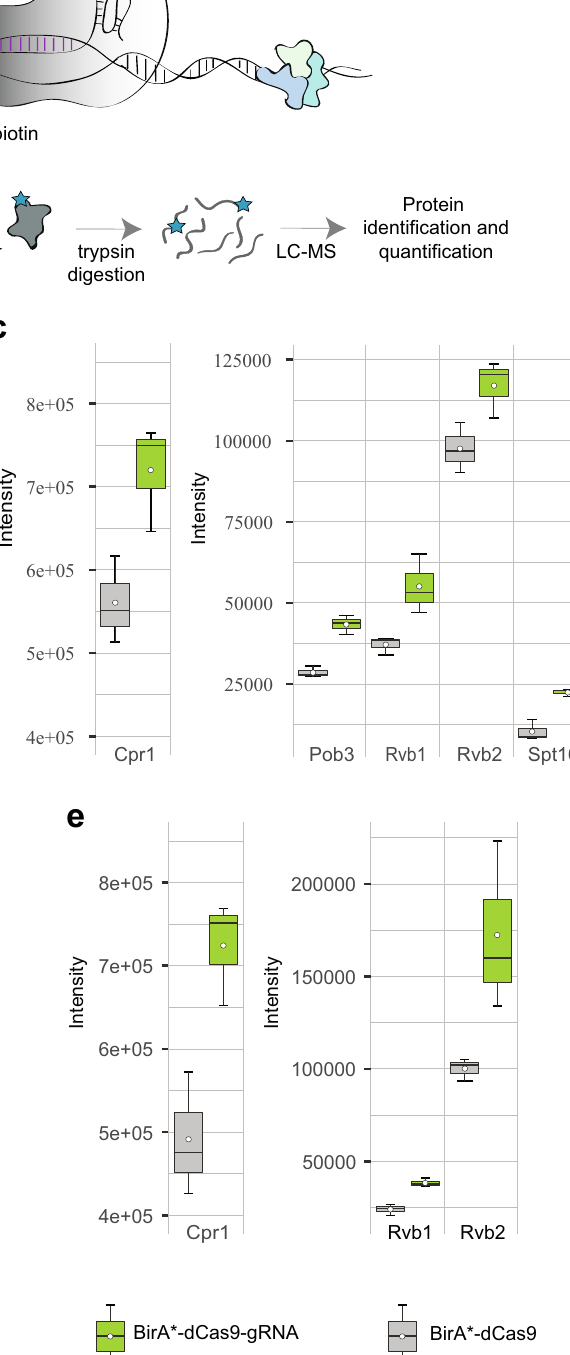
from a two-sided unpaired Student ’ s t test with equal variance are color coded, and thegraydashedlinesrepresent1.5-foldquantityincrease. p -valuesareindicatednext to labels. c , e Box plots of measured protein intensities of candidates from sgRNA- BirA*-dCas9samplesS5( d )and S7( e )triplicatesalongwiththeirrespectivenegative controltriplicates.SourcedataareprovidedasaSourceData fi le.Medianisindicated asmiddleline,averageasawhitedot,25thand75thpercentileasboxesandwhiskers represent 5th and 95th percentile. False discovery rates thresholds for mass spec- trometry identi fi cation of peptide spectrum match, peptides, and proteins were set to 0.1. See also Supplementary Data 1 – 6 and Supplementary Figs. 5 and